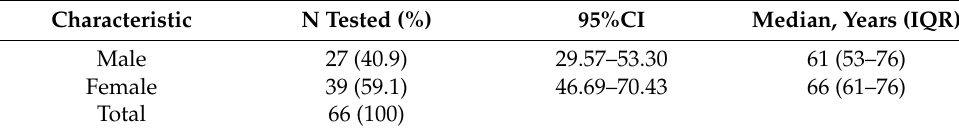
Table 1. Demographic characteristic of patients with WNV disease.